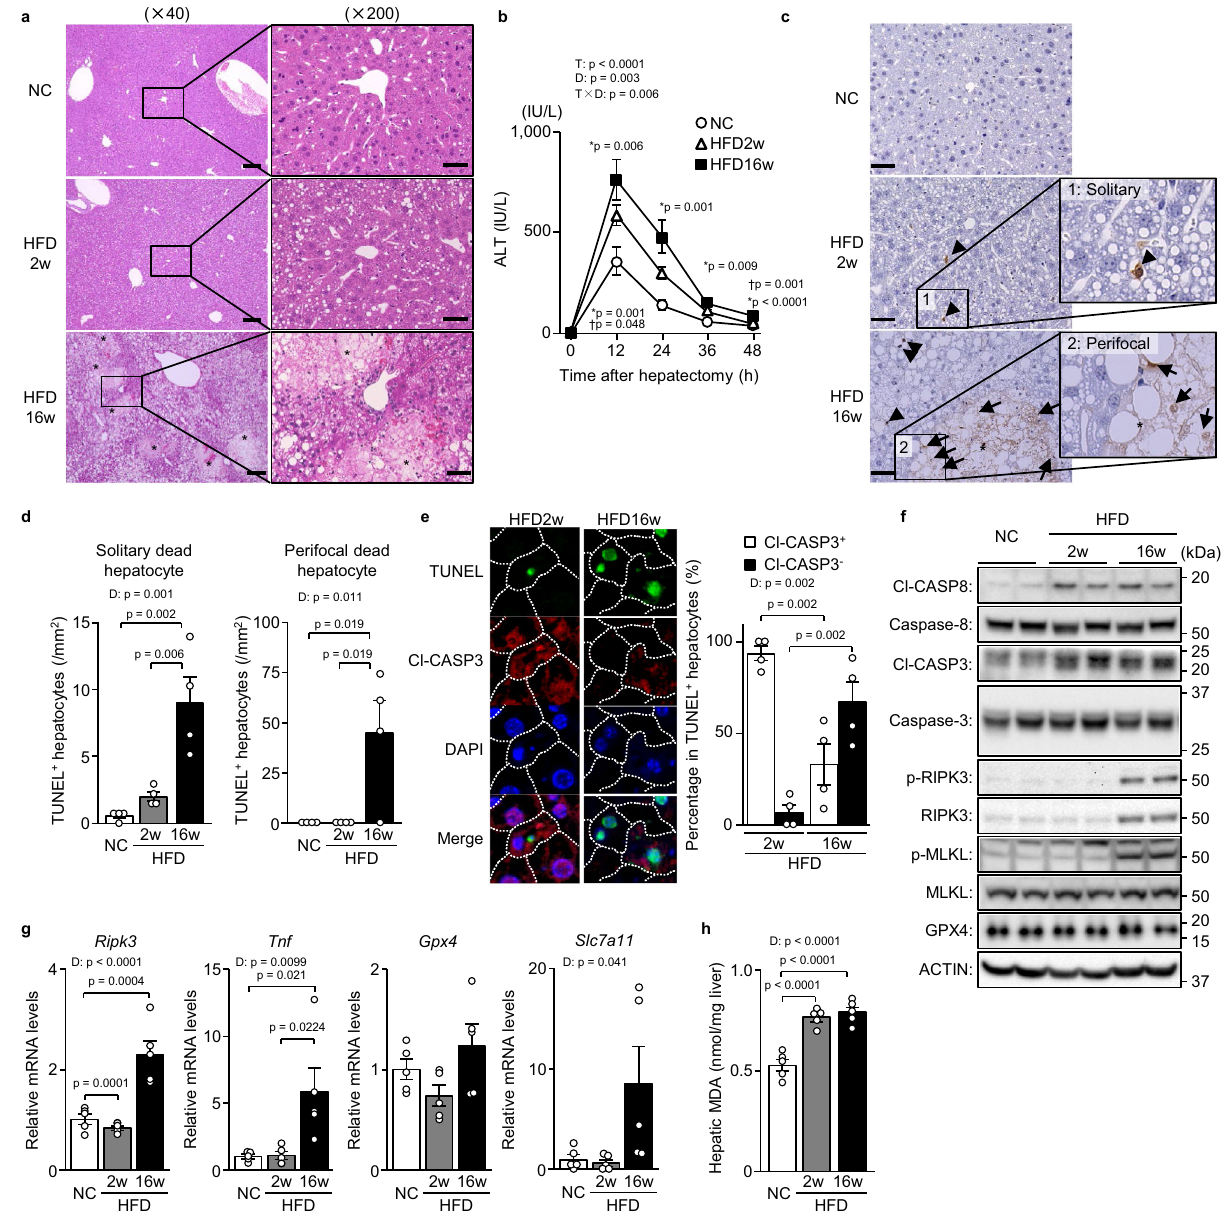
Fig. 1 | Non-apoptotic cell death is increased in severe steatosis after hepa- tectomy. Micefednormalchow(NC)oraHFDfor2or16weeksunderwentpartial hepatectomy. a Haematoxylin-eosin staining. Scale bars, 50 μ m (left) and 200 μ m (right).Asterisksindicatehepatocellulardeathfoci. b PlasmaALTlevels.*indicates p-values for HFD16w versus NC; † indicates p -values for HFD16w versus HFD2w. c TUNELstaining.Scalebar,50 μ m.Arrowheadsindicatesolitarydeadhepatocytes. Asterisks indicate hepatocellular death foci. Arrows indicate perifocal dead hepa- tocytes. d NumberofTUNEL + hepatocytesde fi nedasdescribed. e TUNEL/Cl-CASP3